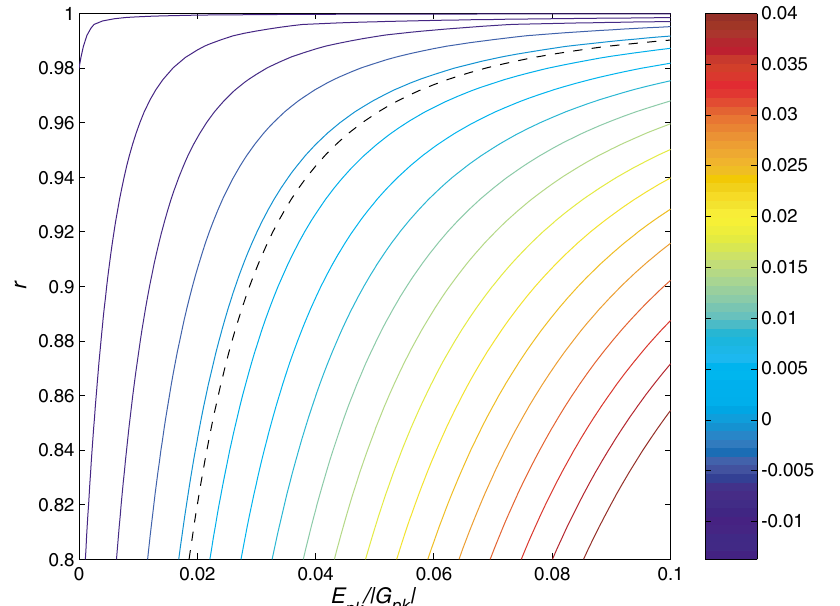
j (cid:1) 0 : 01 , (cid:3) (cid:29)! pk (cid:1) 0 . The dashed black line is (cid:4) (cid:1) (cid:4) f